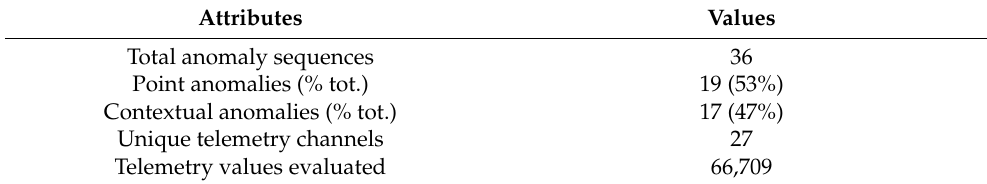
Table 5. MSL Data Table 5. MSL Data Information.